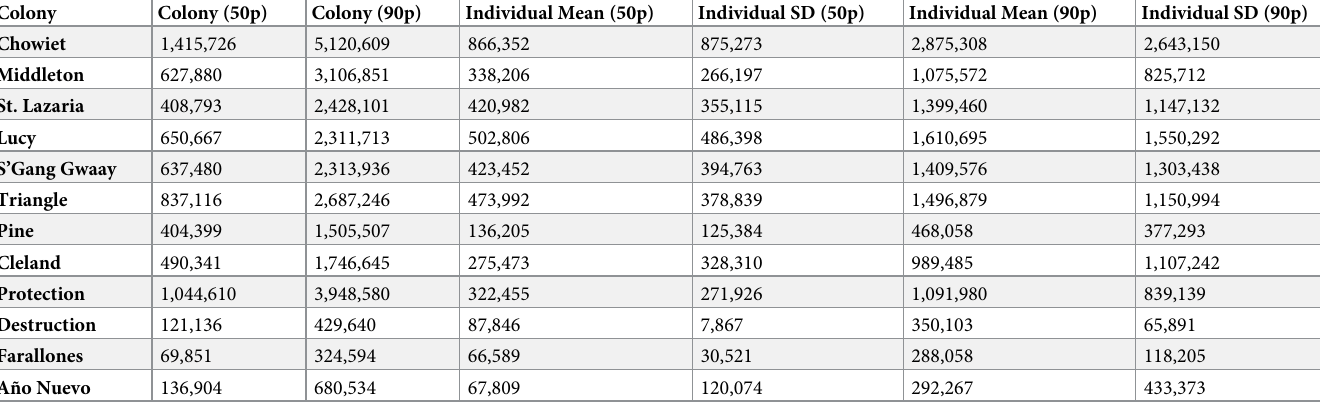
Table 5. Home-range area estimates (km 2 ) during wintering months (Nov-Feb) of rhinoceros auklets breeding at 12 colonies on the Pacific Coast of North America, 2014 to 2016, as calculated from the Utilization Distribution (UD) derived from geolocation of light loggers. Colony